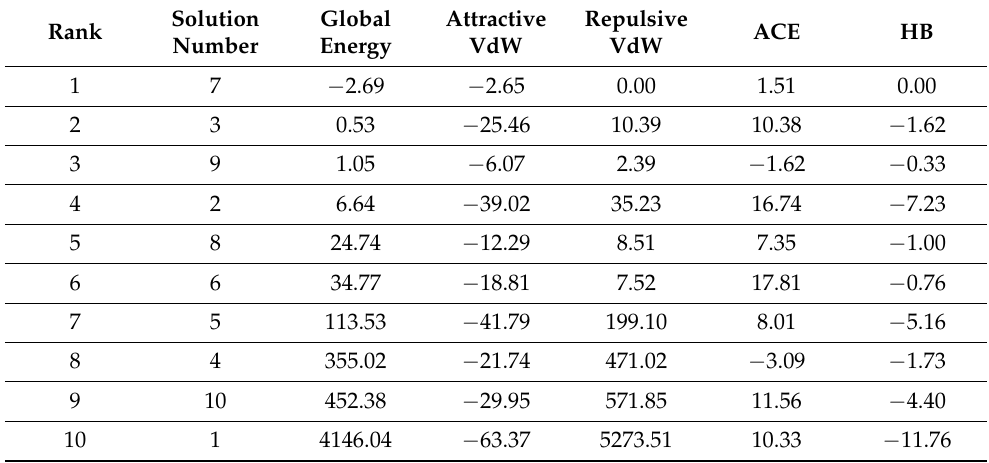
Table 7. Top 10 refined complexes of vaccine and TLR-4 molecule. vdW (van der Waals energy), ACE (atomic contact energy), and HB (hydrogen bond